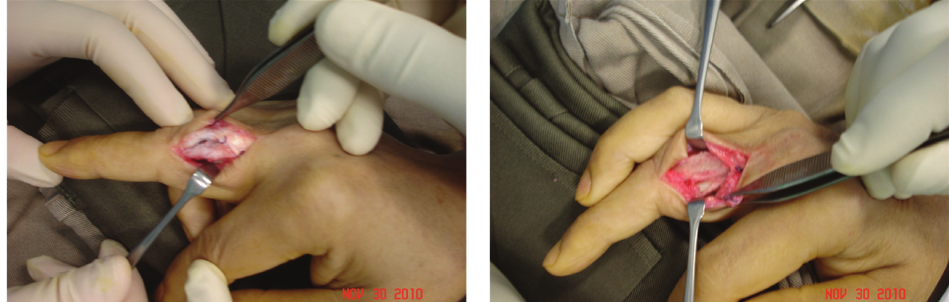
Figure 5: Partly calcified bony tissue up to 18mm × 10mm × 8mm adherent to the proximal phalanx of the middle finger that is located underneath the extensor tendon.